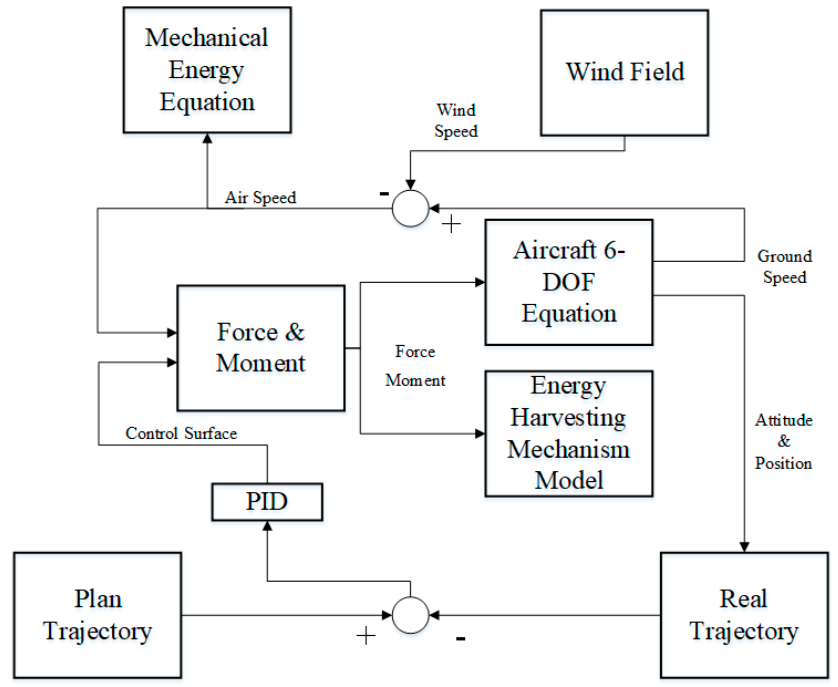
Figure 5. The logic diagram of the dynamic soaring flight simulation model.